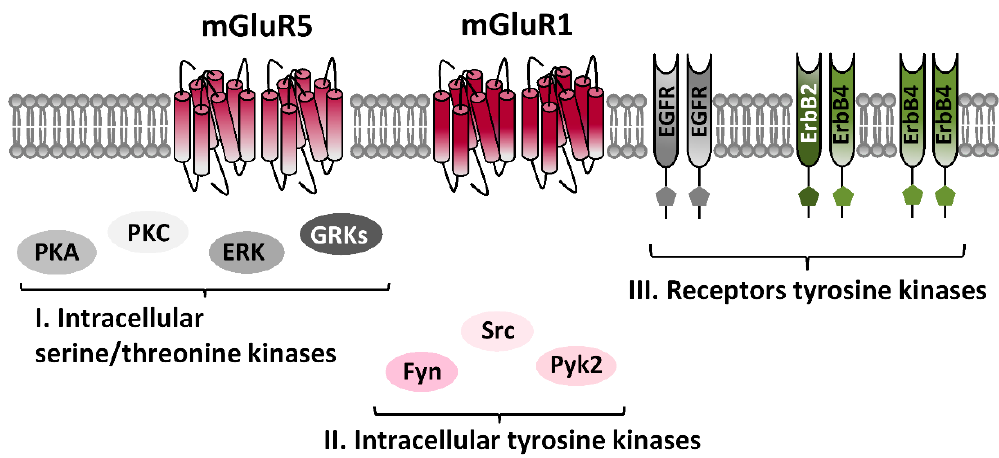
Figure 2. mGluRI interaction with protein kinases. Scheme illustrating protein kinases targeting mGluR1 and mGluR5; they include members of the families of (I) intracellular serine/threonine kinases like G protein-coupled receptors kinases (GRKs), protein kinase A (PKA), protein kinase C (PKC) and extracellular signal-regulated kinases (ERK), as well as (II) intracellular tyrosine kinases, such as Src, Pyk2, and Fyn, and (III) receptors tyrosine kinases, like the epidermal growth factor receptor (EGFR) and avian erythroblastic leukemia viral oncogene homologs (ErbB) receptors, ErbB2-4.